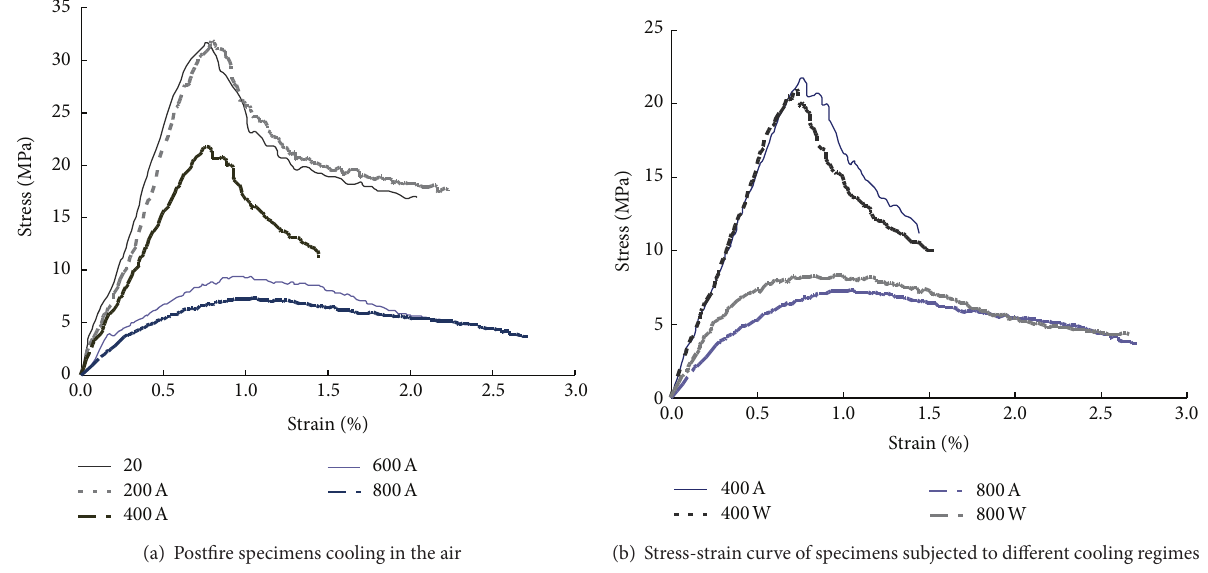
Figure 9: Stress-strain curves of ECC specimens for different curing